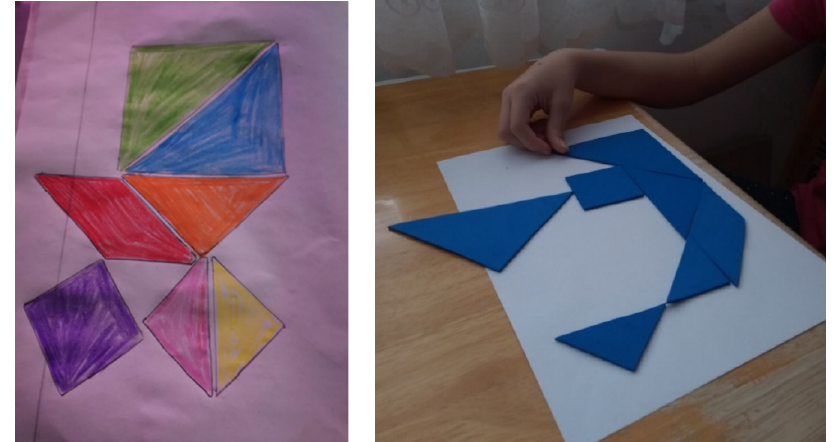
Figure 13. Manifestation of free creativity.